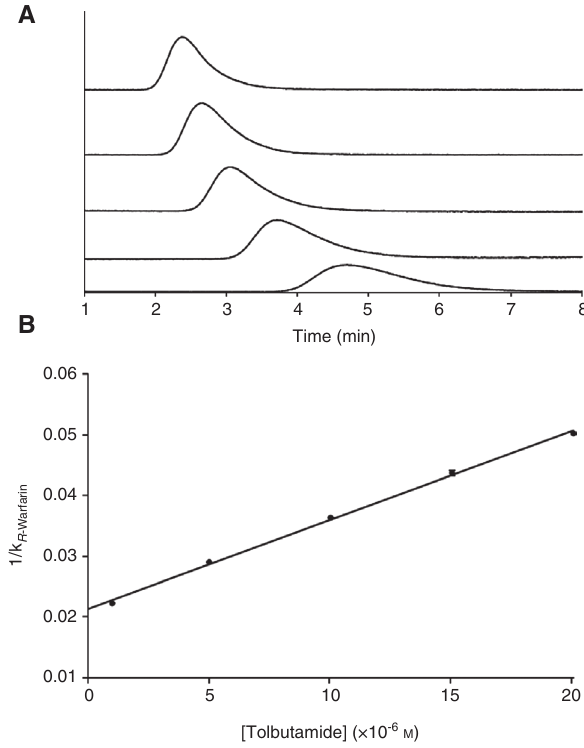
Figure 11 Examples of (A) a competition zonal elution study for injections of R -warfarin in the presence of tolbutamide in the mobile phase on an HPAC column containing glycated HSA and (B) the fit of the resulting shift in retention to Equation (10).